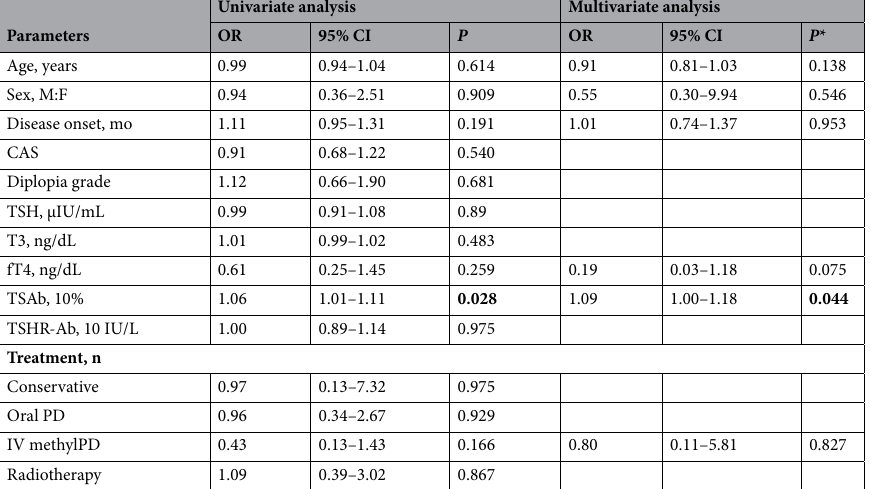
Table 2. Logistic regression analysis of the pre-treatment variables associated with poor prognosis of extraocular muscle movement limitation in the restrictive myopathy associated with thyroid eye disease. mo month, M male, F female, CAS clinical activity score, TSH thyroid stimulating hormone, T3 triiodothyronine, fT4 free thyroxine, TSAb thyroid-stimulating antibody, TSHR-Ab thyroid stimulating hormone receptor antibody, n number, IV methylPD intravenous methylprednisolone, CI confidence interval, OR odds ratio. *Variables with P < 0.20 in the univariate analysis, age, and sex were included in the multivariate